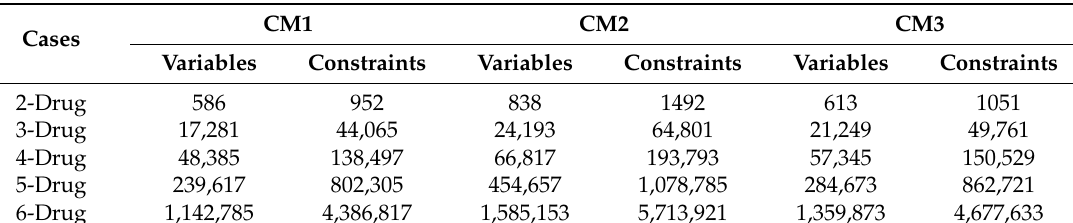
Table 1. Problem sizes for five instances of CM1, CM2 and CM3.